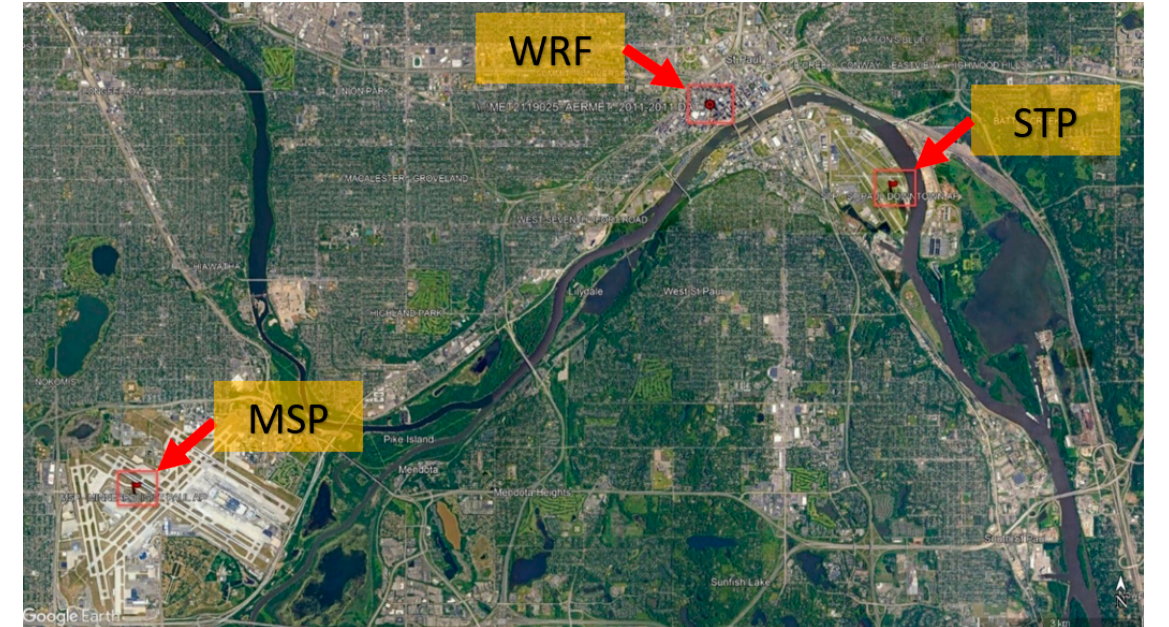
Figure A1. Map Displaying the WRF Center in Saint Paul, Minnesota, along with the nearby Weather Stations at Saint Paul Downtown Airport (STP) and Minneapolis–Saint Paul International Airport (MSP). Map Data: Google Earth.